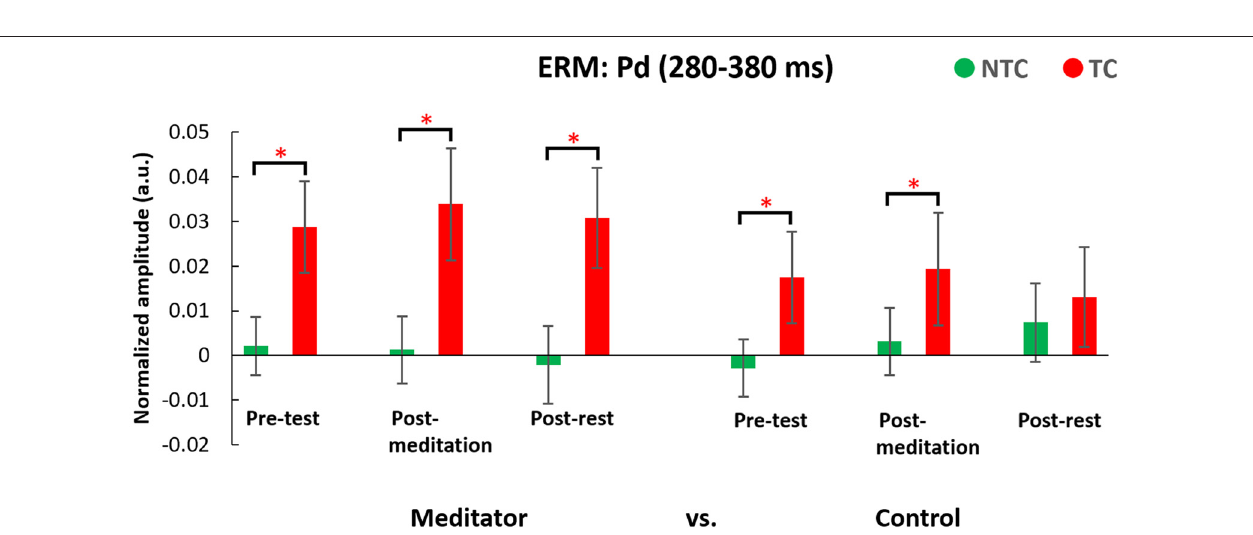
FIGURE 10 | Result of the Pd component ERM analyses. Waveforms were derived from the differences between contralateral and ipsilateral waveforms. Error bars indicate 95% confidence intervals. The asterisks ( ∗ ) indicate statistically significance differences ( p < 0.05).